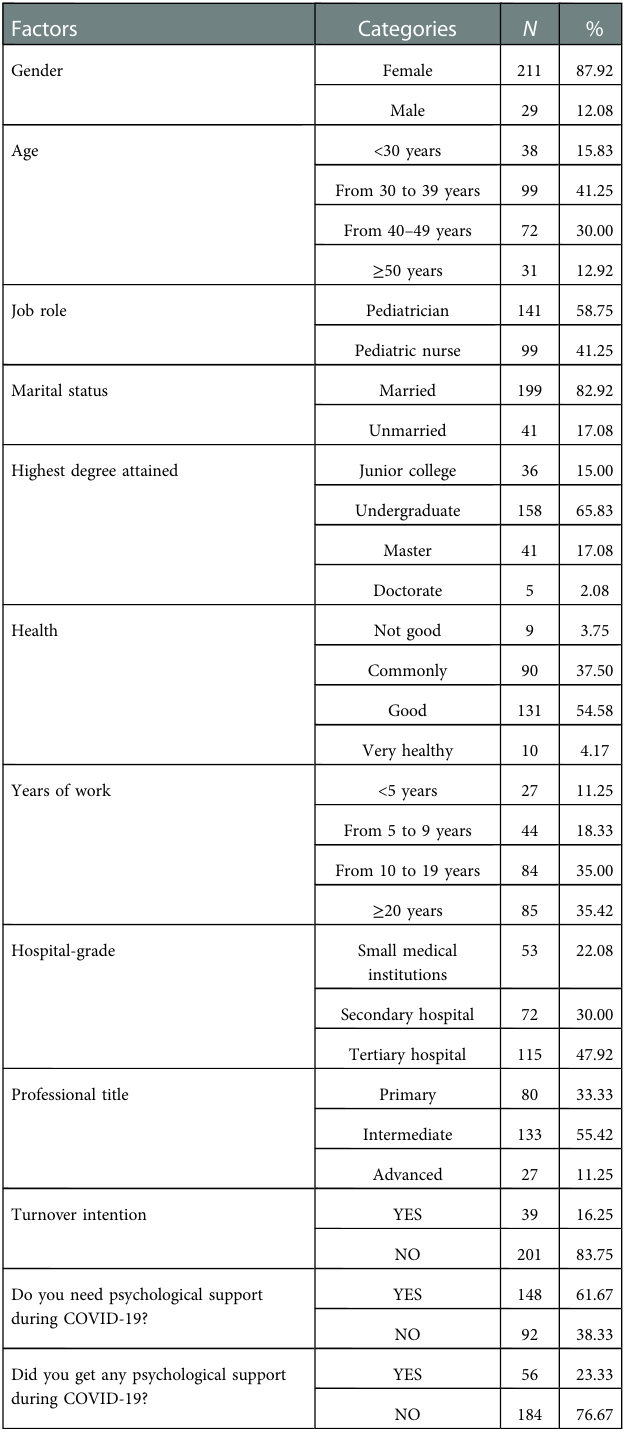
TABLE 1 Socio-demographic data and job characteristics of participants ( n